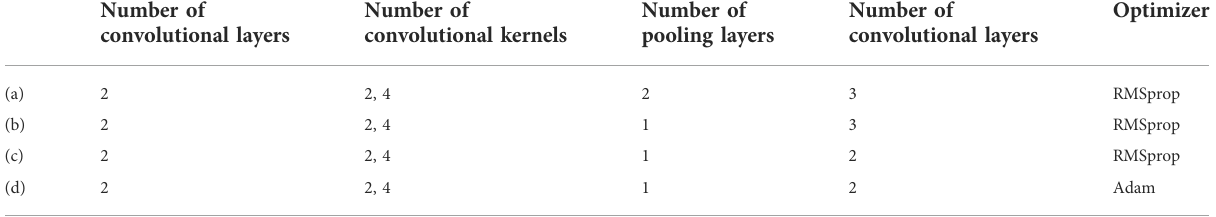
TABLE 1 The parameters used in the fastest convergent scenario.